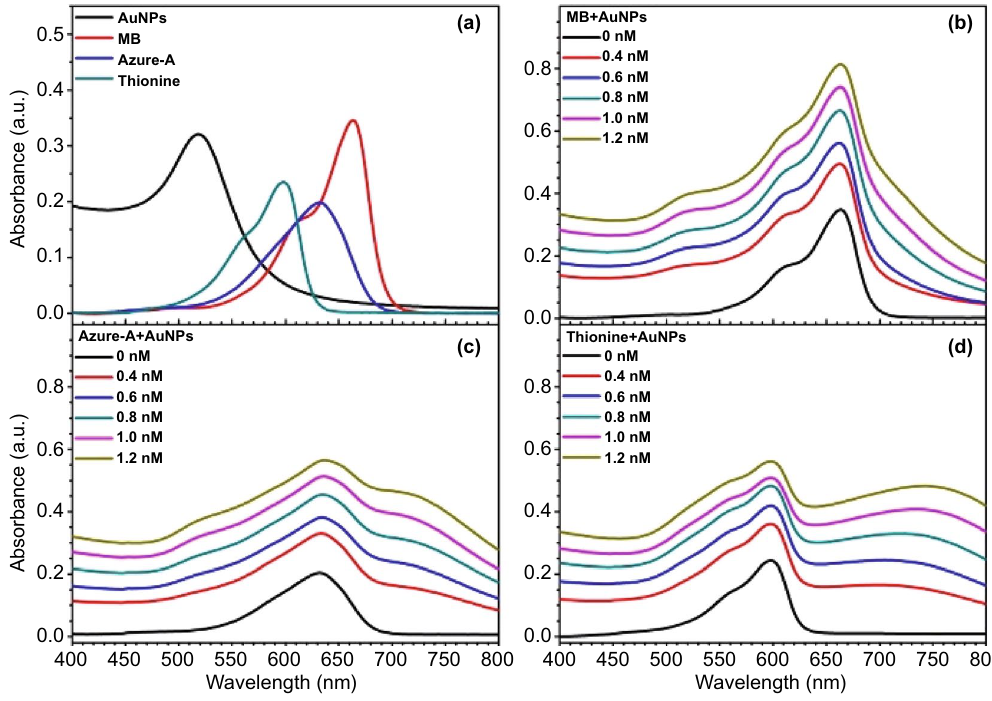
Fig. 16 a Absorbance spectra of AuNPs and three different photosensitizers including Methylene blue, Azure-A, and Thionine. Absorbance spectra of b Methylene blue (5 µM), c Azure-A (5 µM), and d Thionin (5 µM), in the presence of Au NPs (0.6 nM). The absorbance of Au NPs has been subtracted as background, reproduced from Ref. [209] with permission from American Chemical